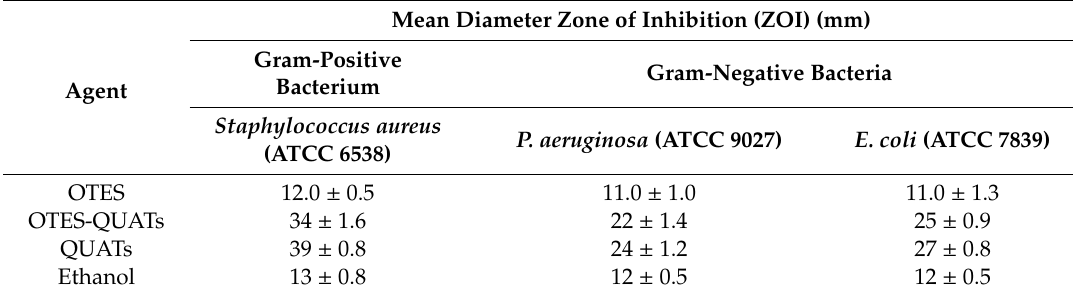
Figure 4. ( a ) Disk di ff usion assay of ethanoic solution of: OTES (Region S1); OTES-QUATs (region S2); (QUATs) (region S3) and Ethanol (region S4), treated against Staphylococcus aureus bacterium. ( b ) Graphical representation of adhesion reduction of Staphylococcus aureus , Pseudomonas aeruginosa and Escherichia coli on OTES / Al, OTES-QUATs / Al, QUATs / Al and etched Al substrate. Table 1. Disk di ff usion assay results of OTES-QUATs samples.